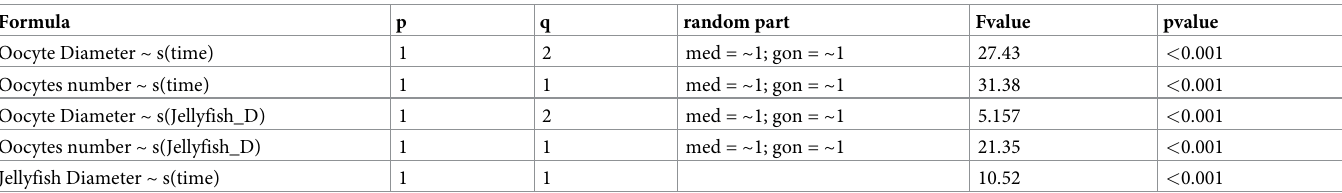
Table 1. Statistical result table. To the left of the tilde ( ~ ) symbol the response variable, and to the right the independent variable. "s" = natural cubic spline smoother; p = autocorrelation term (AR); q = moving average term (MA); med (medusa ID) and gon (gonad ID nested in med) used as random intercept. Jellyfish_D = jellyfish